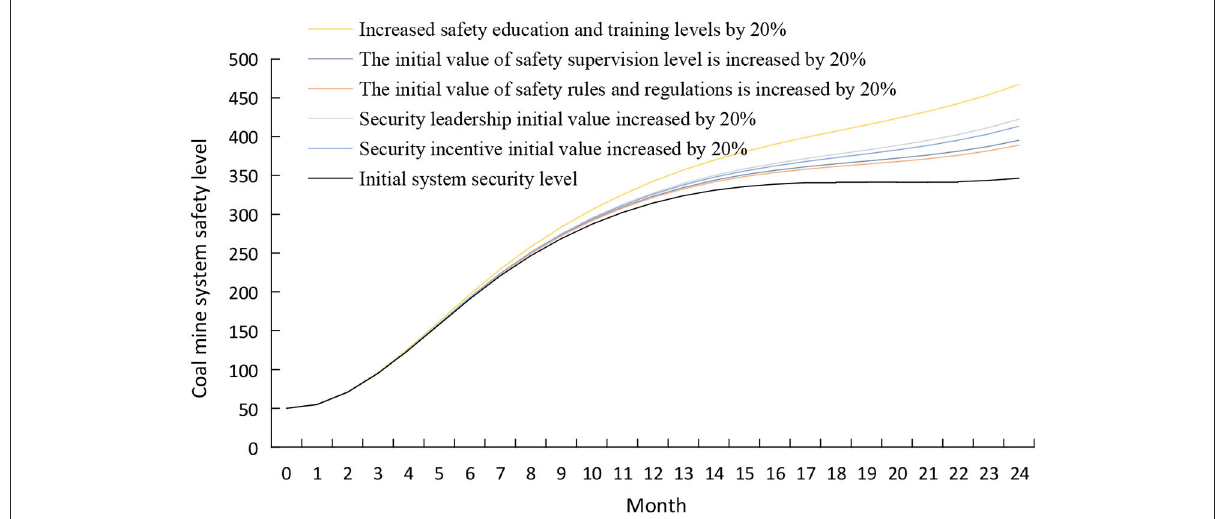
FIGURE9 Simulation results of coal mine system safety after the intervention of the organizational management subsystem.